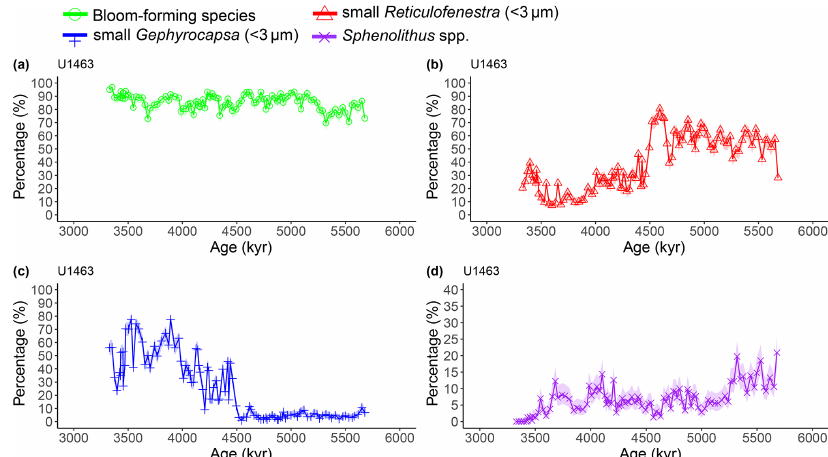
Figure A1. Latest Miocene to early Pliocene relative abundances (%) of the dominant calcareous nannofossil species at IODP Site U1463. (a) Bloom-forming species ( < 5µm Reticulofenestra and < 3µm Gephyrocapsa combined; green circles), (b) small ( < 3µm) Reticulofen- estra (red triangles), (c) small ( < 3µm) Gephyrocapsa (blue plus signs), and (d) Sphenolithus spp. (purple crosses). Shaded areas represent 95% confidence intervals (see Methods). Note the different y axis scale in panel (d) .